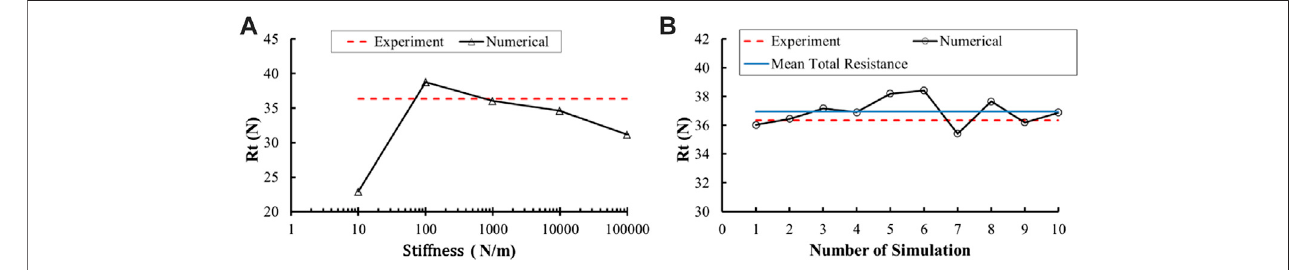
FIGURE 9 | In fl uence of stiffness and